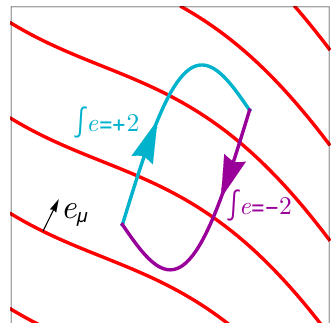
Figure 2: A 2D slice of 3D space showing a single foliation of 2D layers, which appear as red lines in this cross-section. The foliation field e µ points orthogonal to the layers (cid:82) (cid:82) e k e k ≡ d x µ counts the number of layers that the path p crosses. such that µ p p